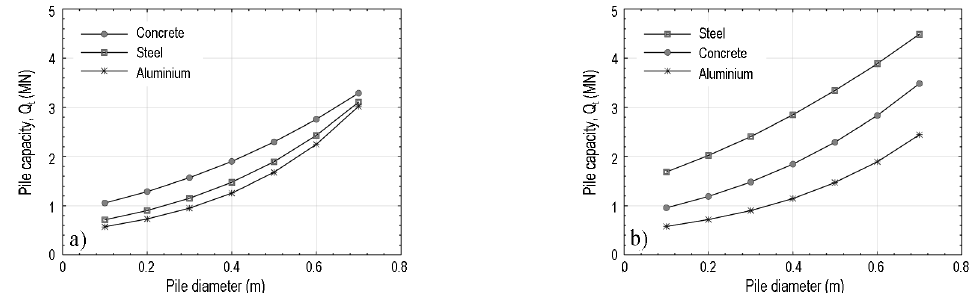
Fig. 12. Effect of pile diameter on pile capacity: (a) Large-displacement pile, (b) Low-displacement